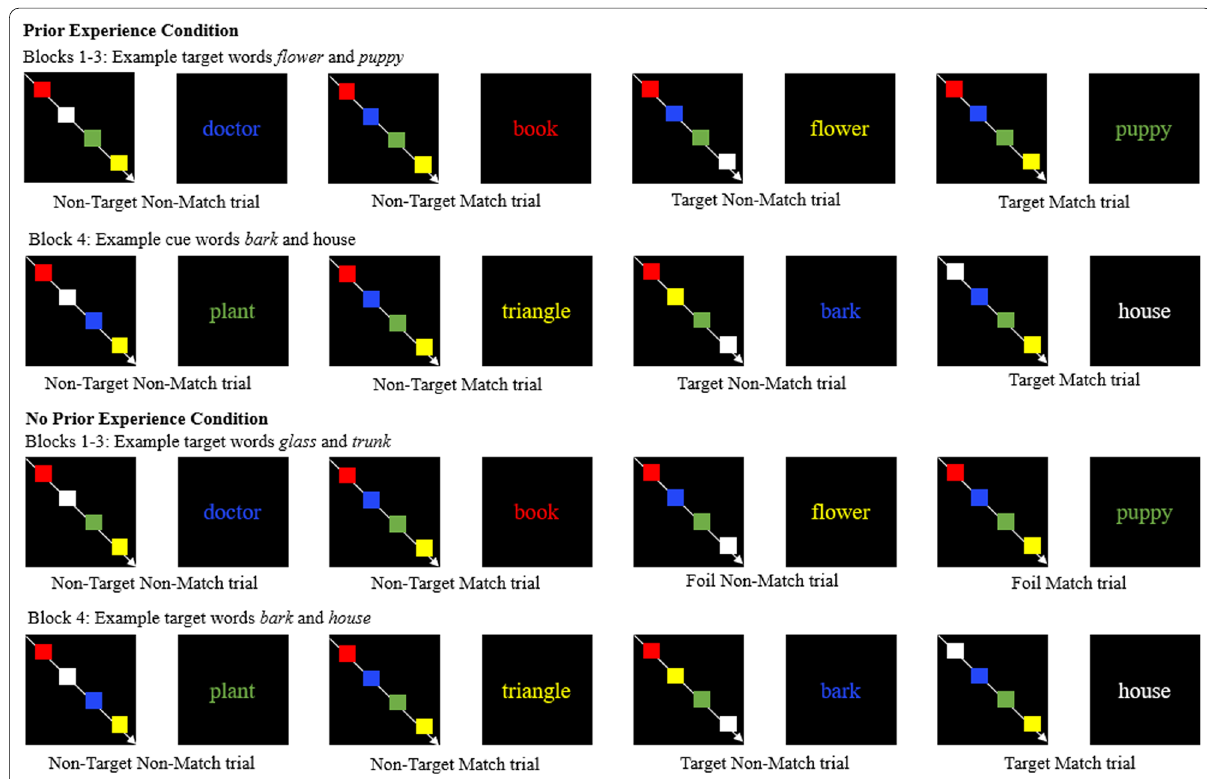
Fig. 1 Example of trial types by block and condition in Experiment 1. Note: The colored rectangles each appeared by themselves on a screen followed by an interstimulus interval. They are presented all together here due to space constraints. The following comprises an example and may not correspond to words actually used on the